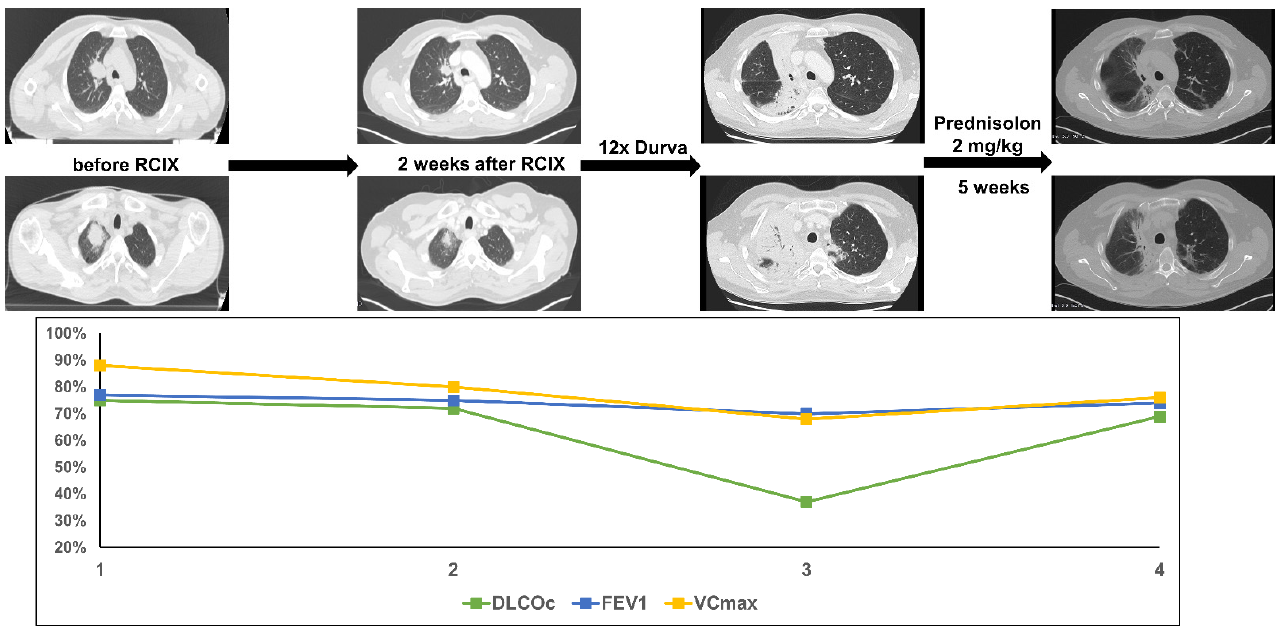
Figure 2. The figure shows course of treatment, corresponding CT imaging and lung function values of patient 2. (RCIX: Radiochemoimmunotherapy; Durva: Durvalumab).